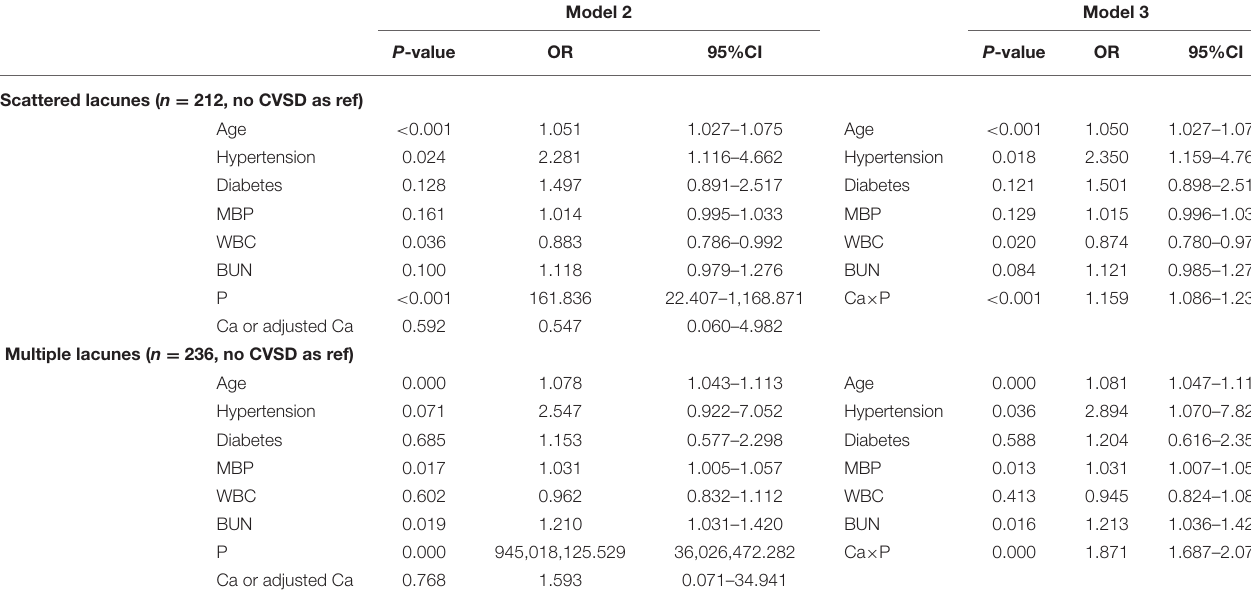
TABLE 4 | Multivariate analysis for factors associated with lacunes by multinominal